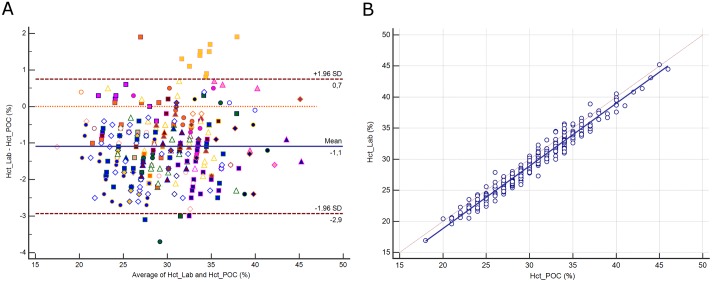
7A. Bland-Altman plot showing the difference versus the average of hematocrit (Hct) measured by the central Lab analyzer and by the POC Siemens RAPIDPoint 500 blood gas system. Bias, upper and lower limits of agreement (±1.96 SD) are represented. The red dotted line indicates equality (difference = 0). There is one marker for each patient. 7B. Scatter diagram showing Deming regression analysis for hematocrit (Hct) measured by the central Lab analyzer and by the POC Siemens RAPIDPoint 500 blood gas system. The regression line (solid line) and the identity line (x = y, dotted line) are represented.